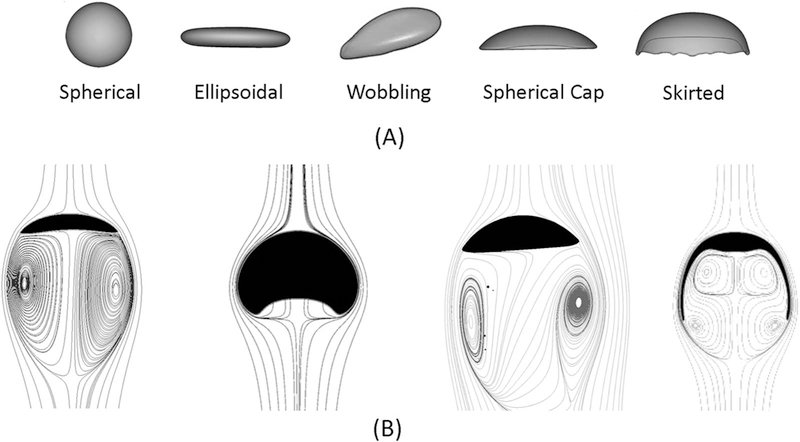
(A) Different shapes of a bubble rising in viscous liquid. The characteristic shape is set by the flow dynamics and fluid properties. (B) Instantaneous streamlines revealing the wakes associated with different bubbles. (From left to right) The rising spherical cap is characterized by a trailing ring wake. The spherical bubble has a smooth wake. Rising elliptical bubbles have a helical vortex wake, and skirted bubbles feature vortex ring wakes. The figure is reproduced from Gumulya et al., 2016.126